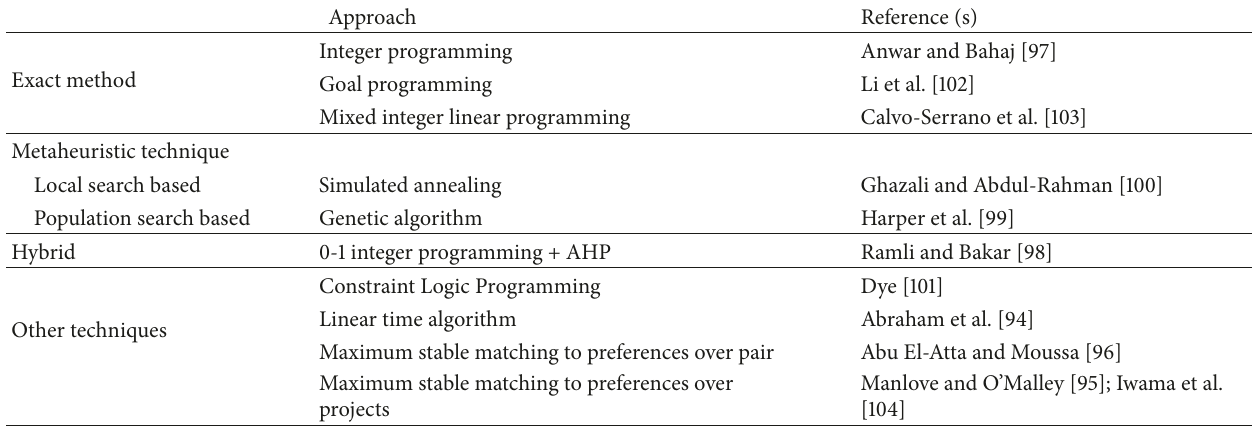
Table 12: Summary of related studies to SPAP.